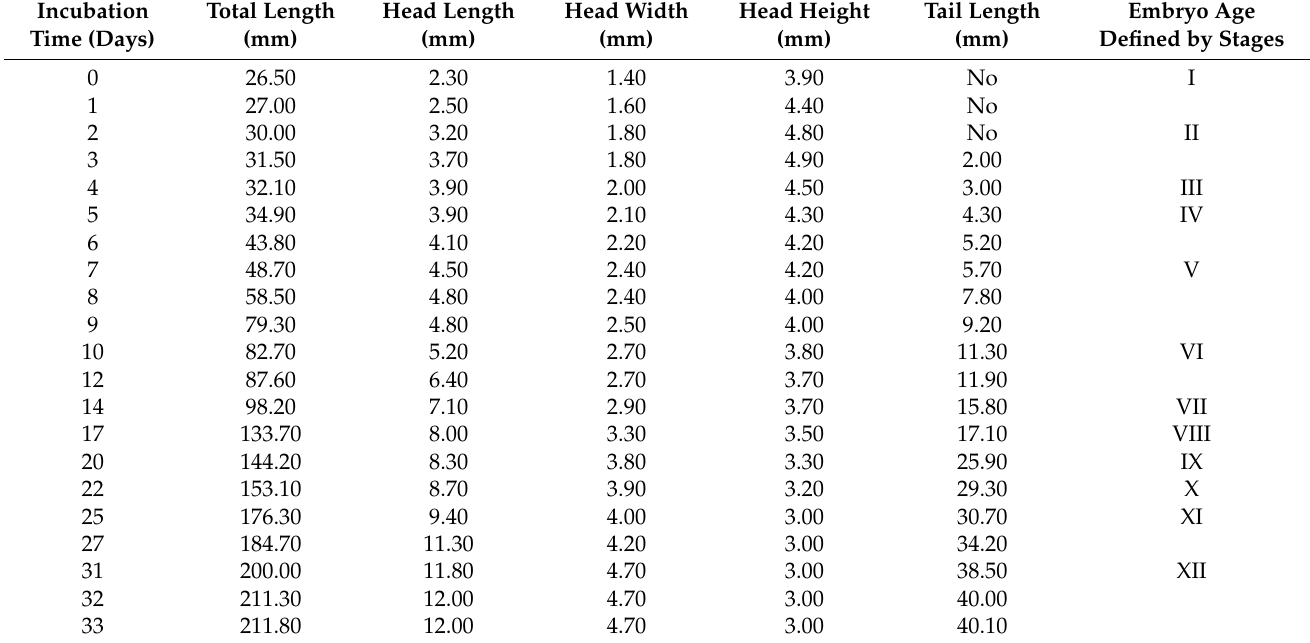
Table 1. The relationship between incubation time and embryo body size